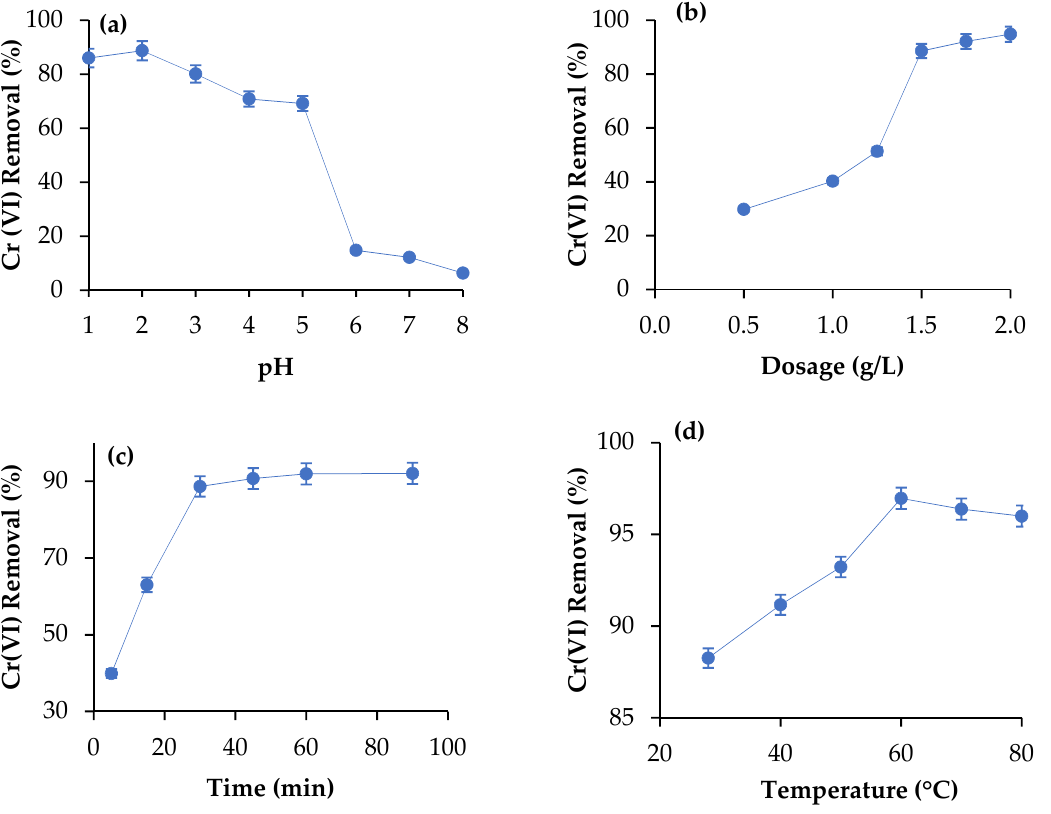
Figure 4. Removal of Cr(VI) from aqueous solution using CNCs isolated from waste cotton cloths: ( a ) effect of pH, ( b ) effect of doses (g/L), ( c ) effect of treatment time, and ( d ) effect of temperature (°C).